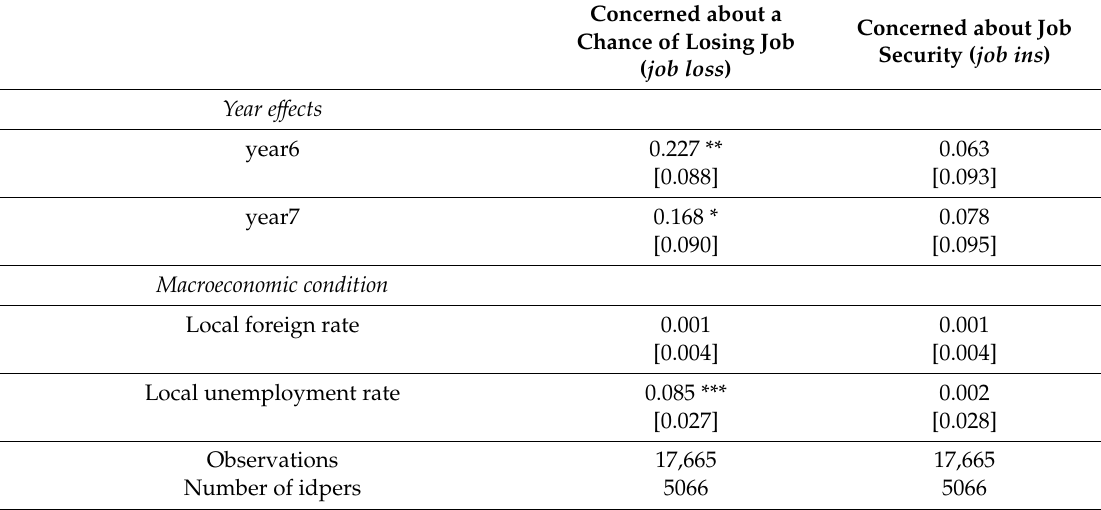
Table 3. Cont. Concerned about